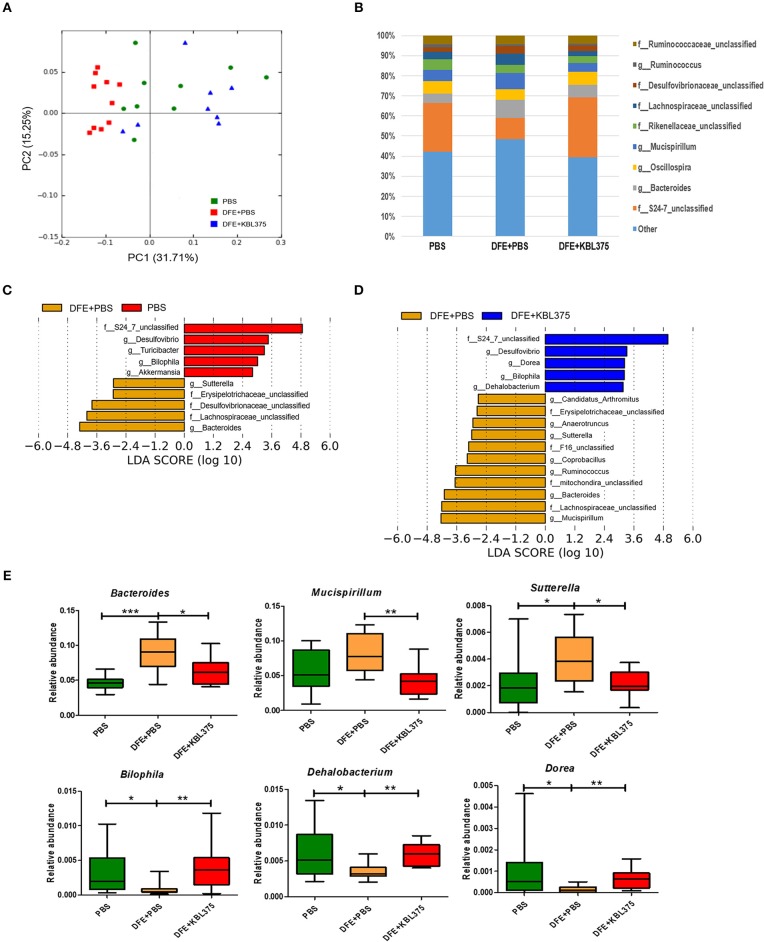
The effects of L. fermentum KBL375 on cecum microbiota of mice. (A) Principal coordinate analysis (PCoA) plot of the cecal microbiota with weighted UniFrac distance; (B) Taxonomic shifts in cecum microbiota for L. fermentum KBL375 treatment at the genus level; (C) Different taxa with significance measured using linear discriminant analysis effect size analysis for mice treated with PBS compared to mice treated with DFE + PBS (threshold >2.5); (D) Different taxa with significance measured using linear discriminant analysis effect size analysis for mice treated with DFE + L. fermentum KBL375 compared to mice treated with DFE + PBS (threshold >2.5); (E) Comparison of abundances of significantly different microbial taxa. Asterisks indicate a statistical significance (*P < 0.05; **P < 0.01; ***P < 0.001; Mann-Whitney U test compared to mice treated with DFE + PBS as a positive control).